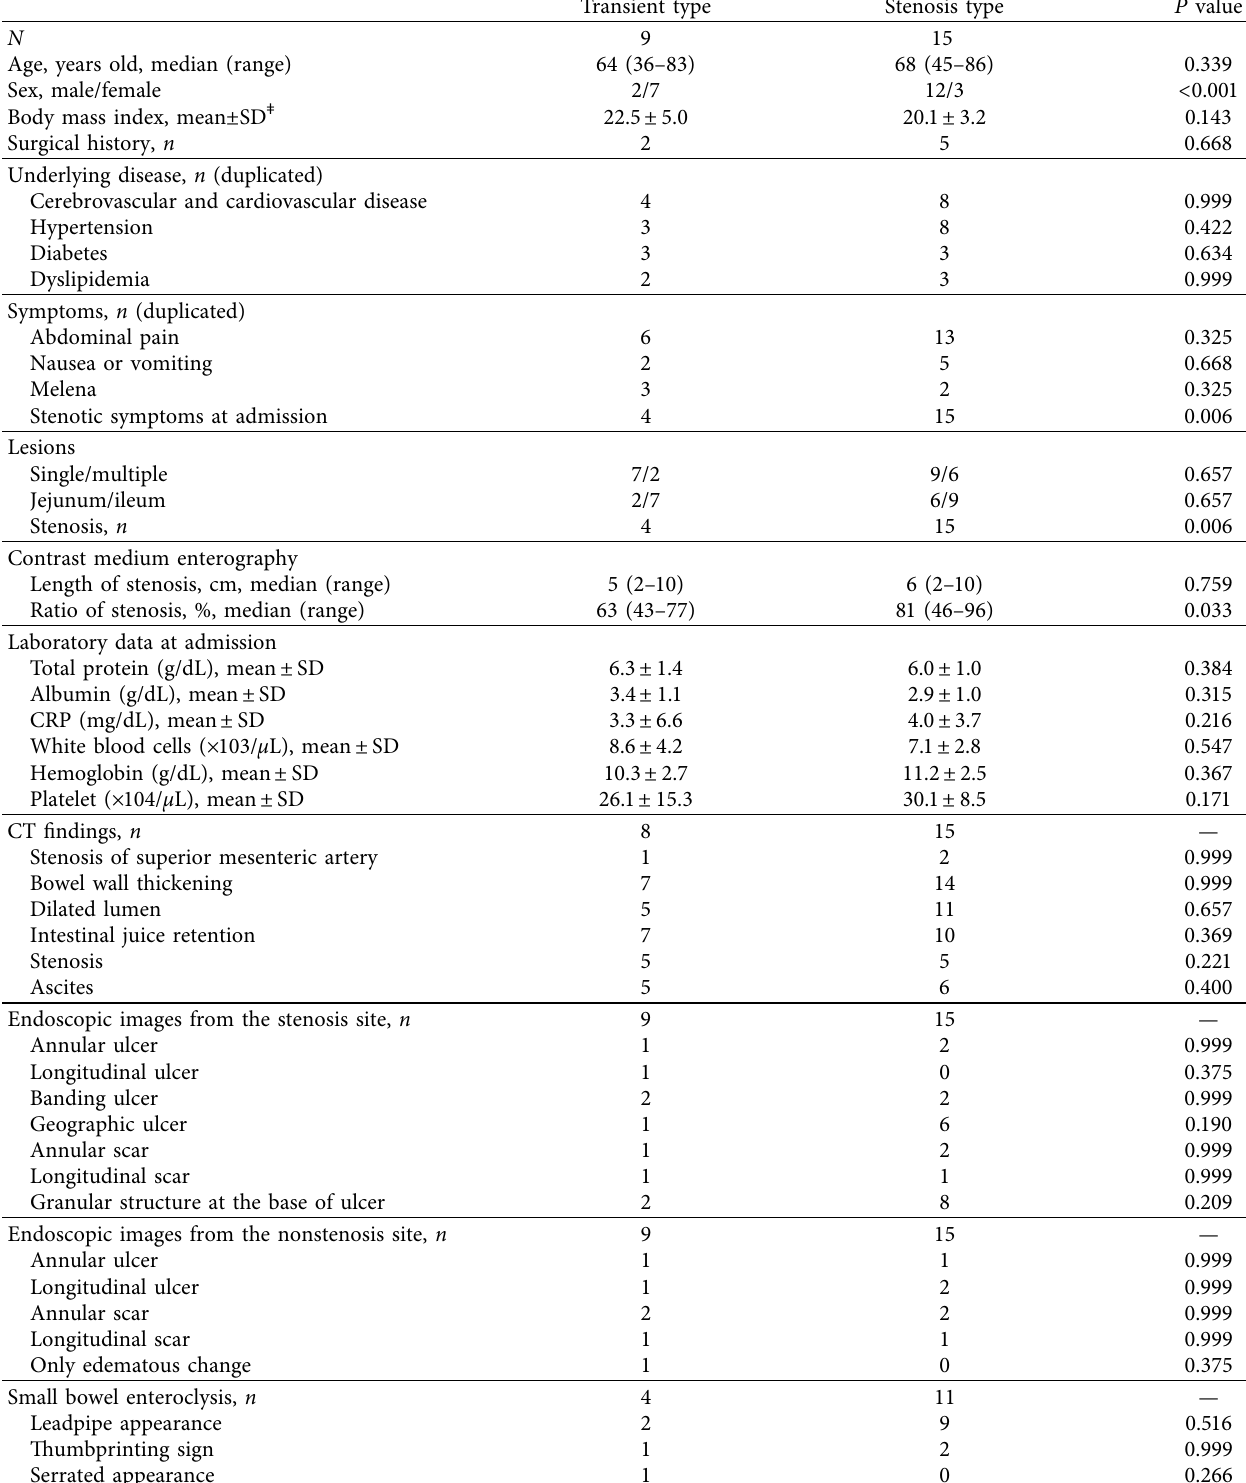
Table 3: Comparing transient and stenotic ischemic enteritis based on patients’